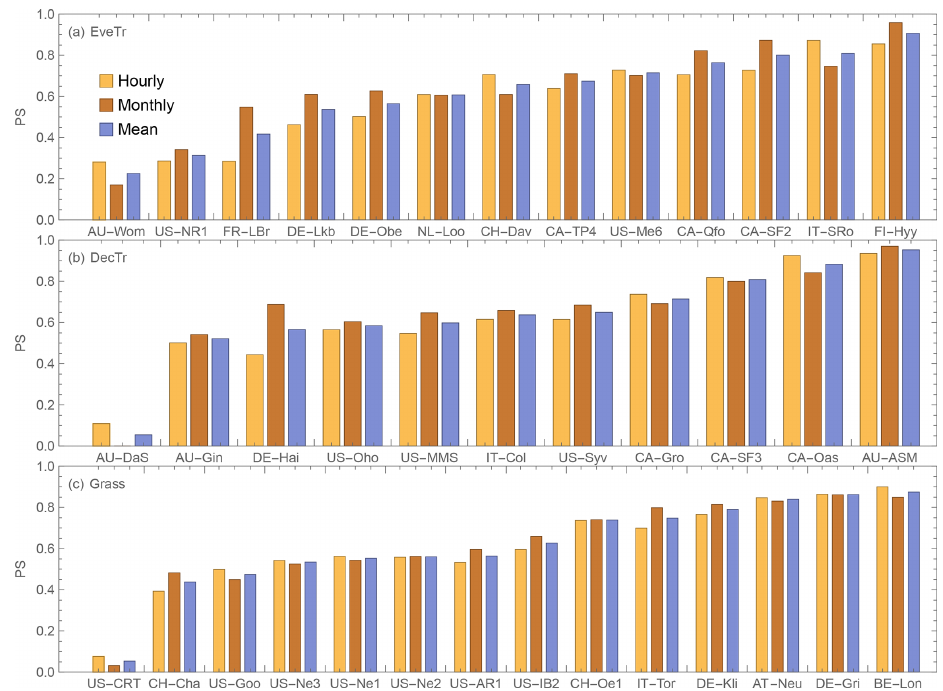
Figure 18. Performance score (PS, Eq. 35, higher value better) using FLUXNET2015 derived parameters for sites (Table 3) from three PFT: